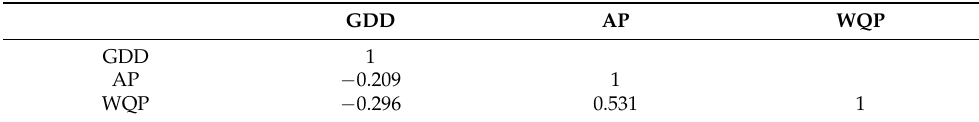
Table A1. Correlations between environmental variables (Pearson). GDD: growing degree days; AP: annual precipitation; WQP: warmest quarter precipitation.